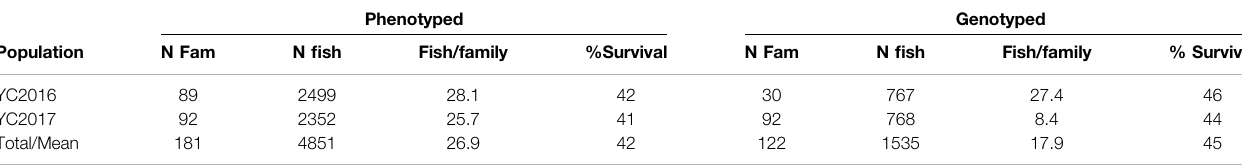
TABLE 1 | Data statistics for the survival